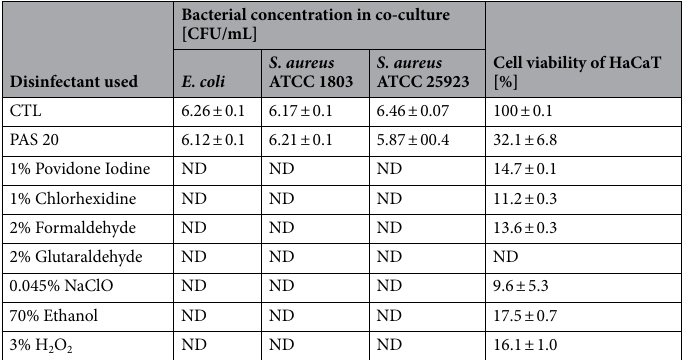
Cell viability of HaCaT [%] E. coli